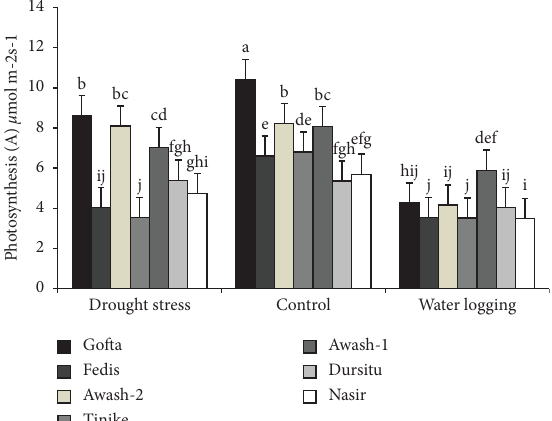
Figure 3: Efects of variety and irrigation interval interaction on the photosynthesis rate under Lath House